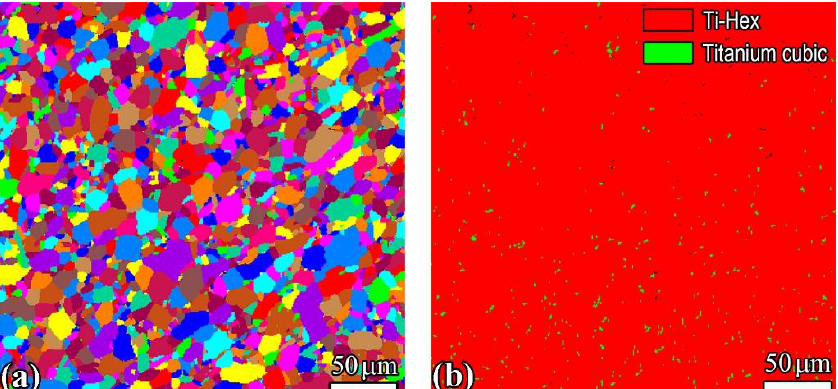
Figure 2. Microstructure of the Ti-6Al-4V ELI alloy. ( a ) EBSD grain map and ( b ) EBSD phase map corresponding to ( a ).